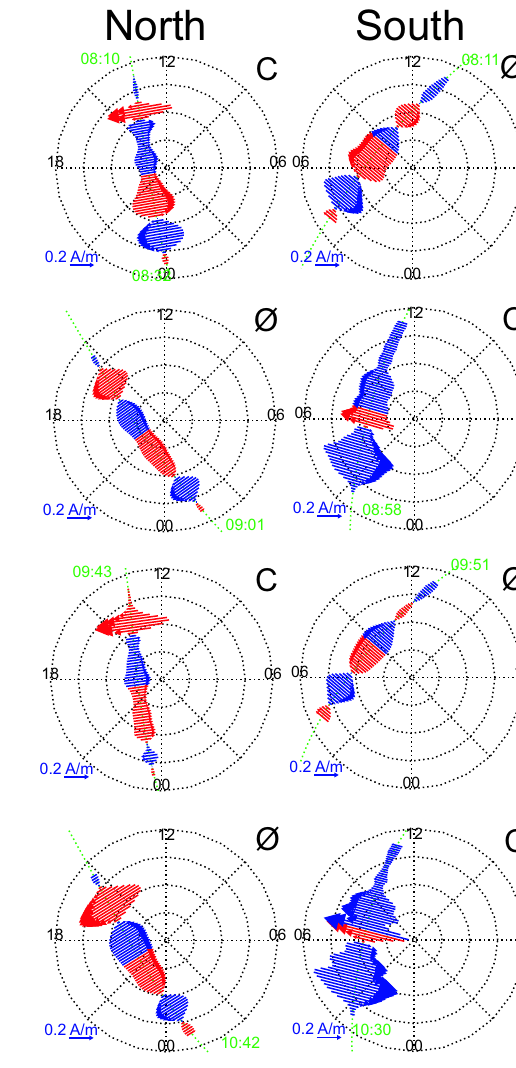
Fig. 5. The ionospheric maps of the derived currents for a sequence of orbits for which Ørsted and CHAMP passed opposite poles nearly simultaneously are shown here. The format of the polar maps is the same as in Fig. 1. In the upper right corner of each map is indicated which satellite produced the map, Ø for Ørsted and C for CHAMP. Successive pairs of near-simultaneous north and south passes are displayed in two columns (of two maps each), starting at the top of the left column, going down through the left column, and then continuing from top to bottom through the right column. In each pair, the northern pass is to the left and the southern pass to the right, as indicated at the top of the